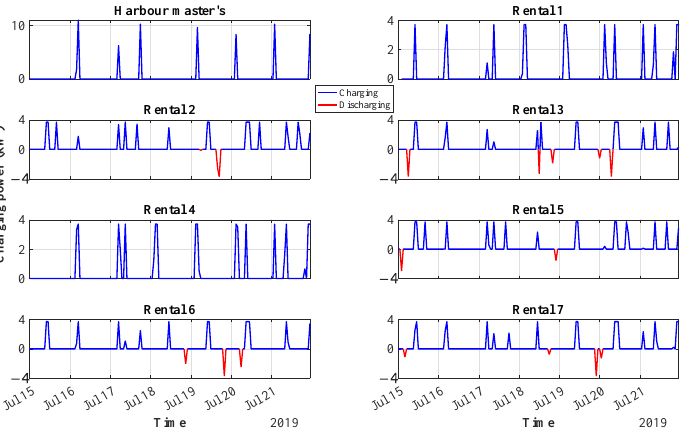
Figure 13. Optimal bidirectional power flow strategy for the future